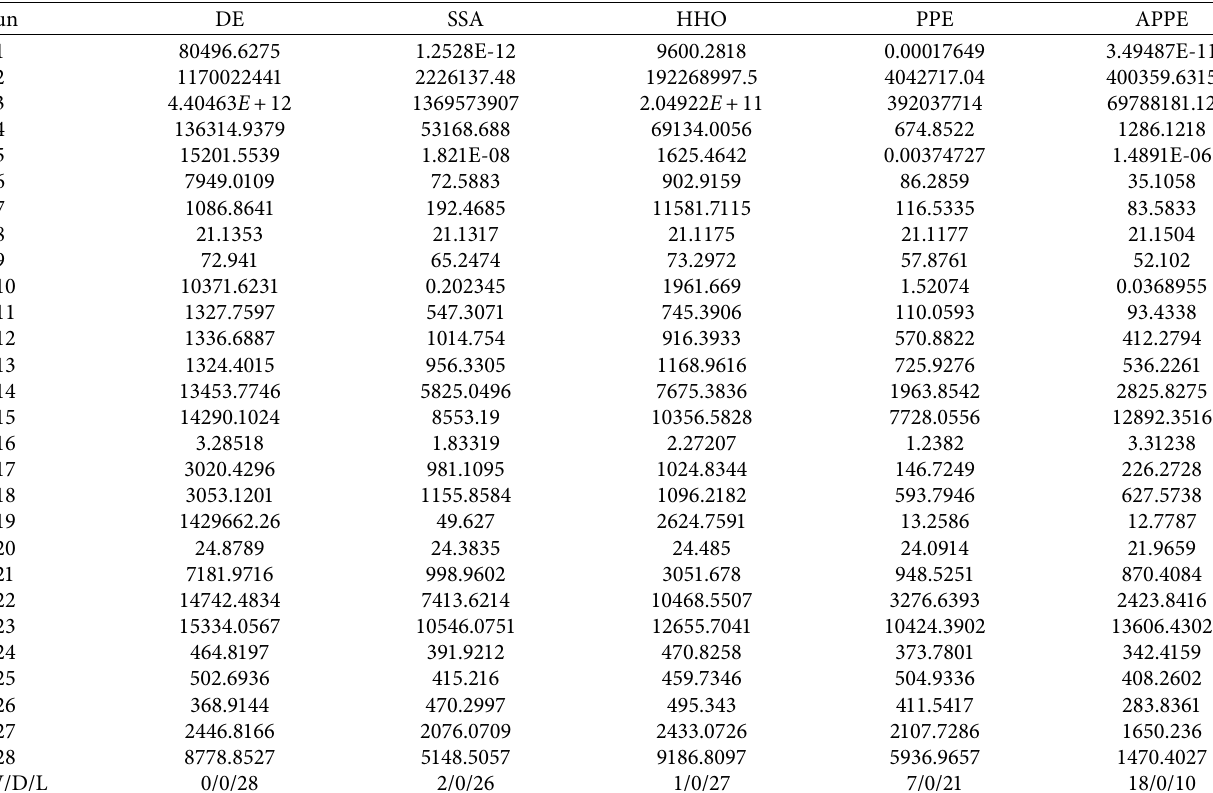
Table 11: Comparison of the mean result of 51 runs on 50D in 28 benchmark